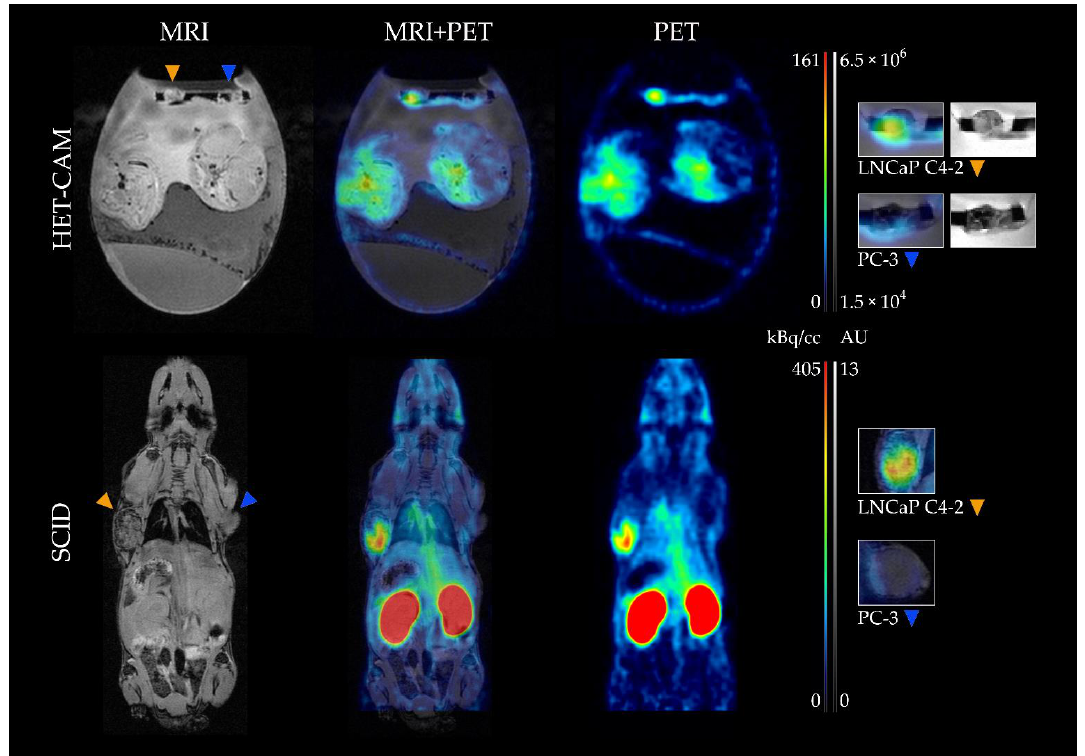
Figure 2. Representative MR and PET images of chick embryo and mice with corresponding fusion image. Anatomy of the chick embryo and mice was obtained by a T1-weighted Flash scan ( left ) while a static reconstruction of a 60 min PET scan was used to demonstrate the biodistribution of the radioligand ( right ). In the resulting fusion image ( middle ), clear accumulation of [ 18 F]F-siPSMA-14 could be localized in the PSMA-positive tumor LNCaP C4-2 (orange arrow) while for PC-3 (blue arrow), a weak signal was observed for both in vivo models. Magnified views of the corresponding tumor regions are depicted on the right. For the HET-CAM model, the images were based on the T2-weighted RARE scan and for the mice, on the T1-weighted Flash images. The PET signal in the HET-CAM model is clearly localized in the LNCaP C4-2 tumor, whereas the weak signal slightly below the PC-3 tumor was caused by an adjacent blood vessel.